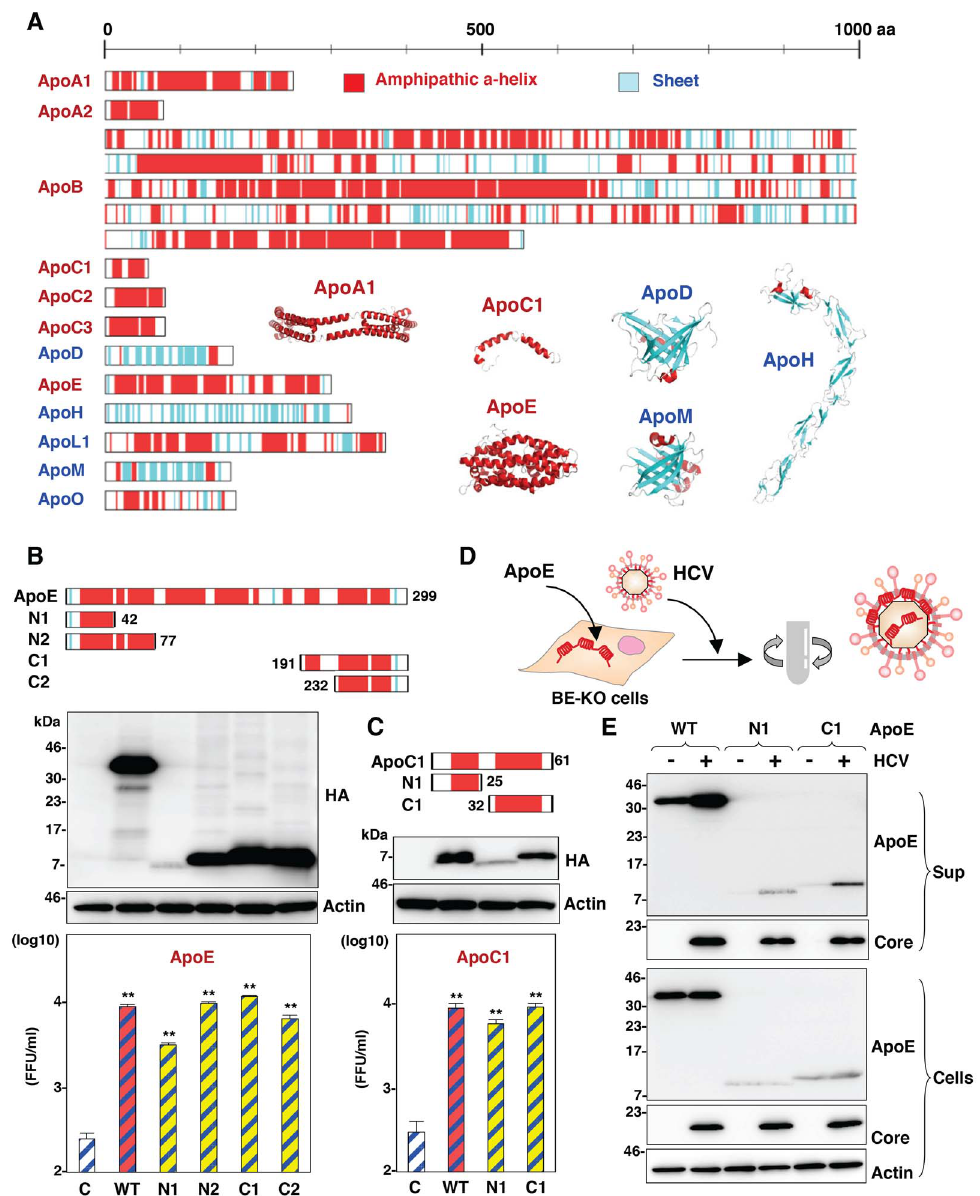
Figure 8. Amphipathic a -helices in apolipoproteins participate in the infectious particle formation of HCV. (A) Predicted or experimentally determined secondary structures of apolipoproteins. Secondary structures of the helices and sheets in the apolipoproteins are colored red and cyan, respectively. The three-dimensional structures of ApoA1 (Protein Data Bank (PDB) ID, 3R2P), ApoC1 (PDB ID, 1IOJ), ApoD (PDB ID, 2HZR), ApoE (PDB ID, 2L7B), ApoH (PDB ID, 1C1Z) and ApoM (PDB ID, 2XKL) are also shown in a ribbon model using the same color code of secondary structures. In cases in which the structure was not available, the secondary structure was predicted by using a CLC Genomics Workbench. (B,C) Schematics of the ApoE- and ApoC1-deletion mutants (upper). Deletion mutants with HA tags expressed in BE-KO1 cells by lentiviral vectors were detected by immunoblotting (middle). BE-KO1 cells expressing the WT or deletion mutants of ApoE or ApoC1 were infected with HCVcc at an MOI of 1, and infectious titers in the culture supernatants were determined by focus-forming assay at 72 h post-infection. Asterisks indicate significant differences (**, P , 0.01) versus the results for control cells. (D) Schematic of the concentration of viral particles from HCV-infected cells using ultracentrifugation. (E) BE-KO1 cells expressing the WT or deletion mutants of ApoE were infected with HCVcc at an MOI of 1. Culture supernatants harvested at 72 h post-infection were concentrated by ultracentrifugation at 32,000 rpm for 2 h at 4 u C, and subjected to immunoblotting.